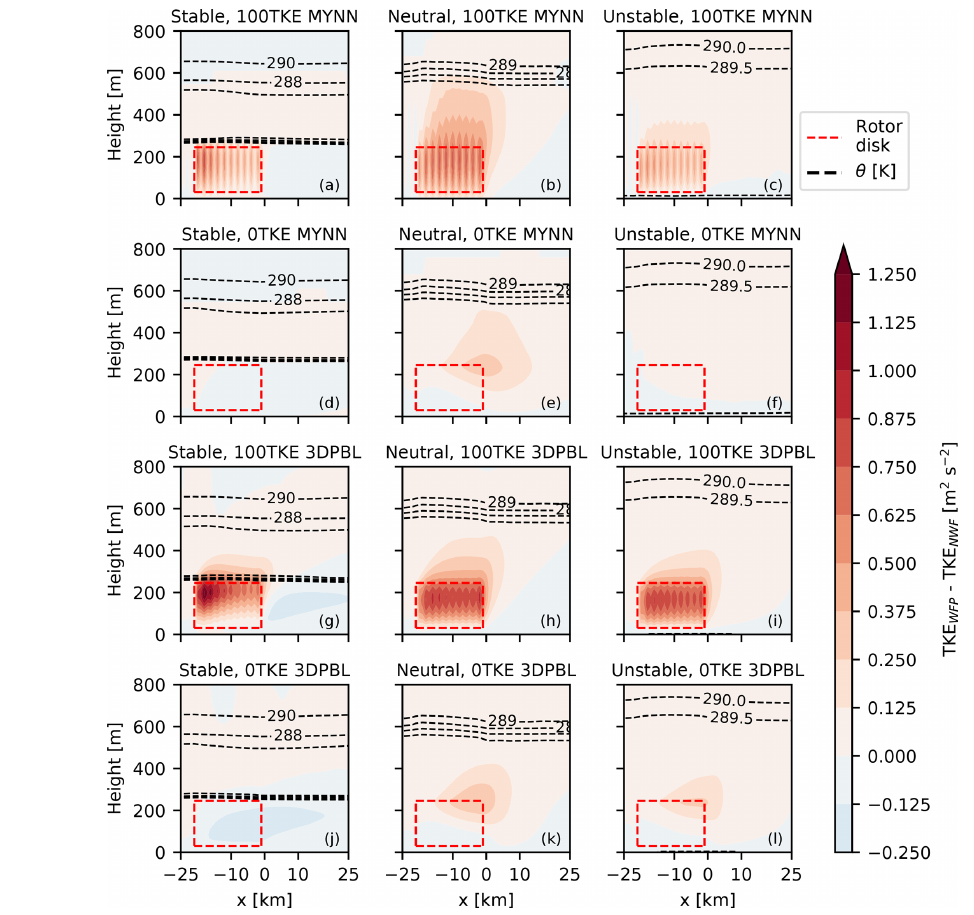
Figure 6. Same as Fig. 4, but for TKE in varying stabilities (left–right) and PBL configurations (up–down). The height of the ABL is visualized in the stable and neutral simulations with θ